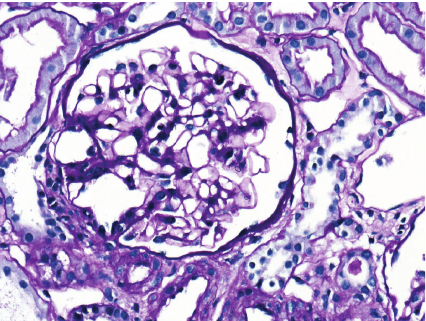
Figure 2: Electron microscopy of the renal biopsy reveals partial effacement and flattening of podocyte foot processes. The glomeru- lar basement membrane is normal. No immune complex deposits are detected (4000x).